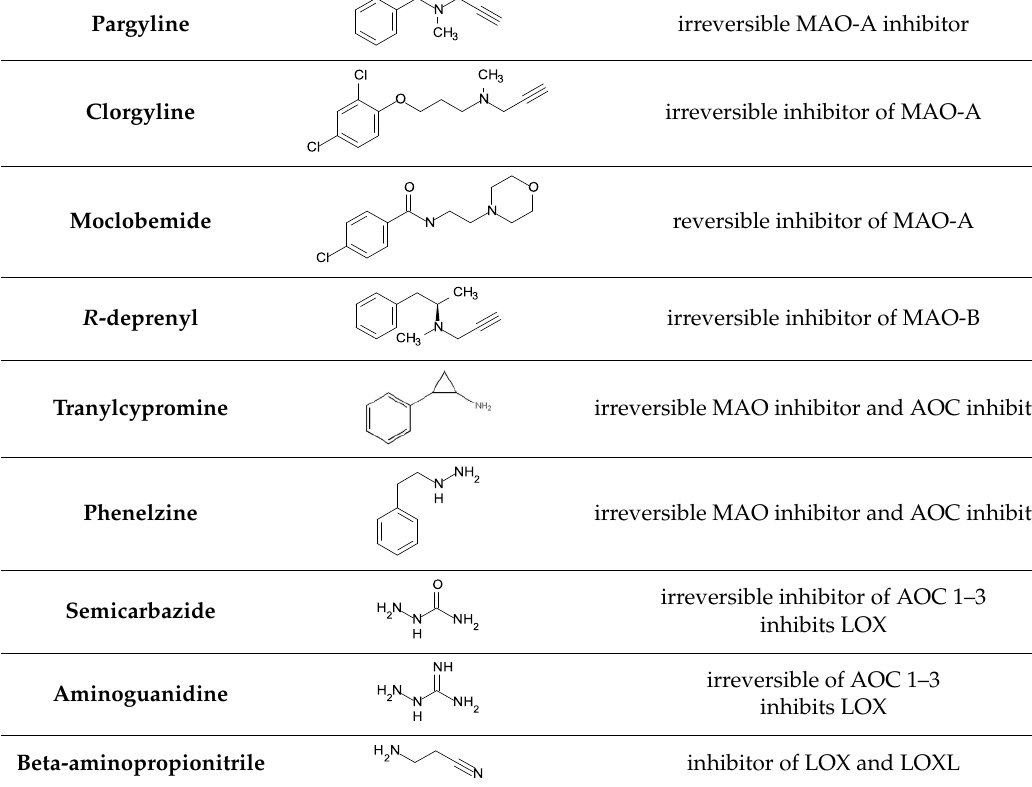
Table 2. Amine oxidase inhibitors, names and chemical structures.